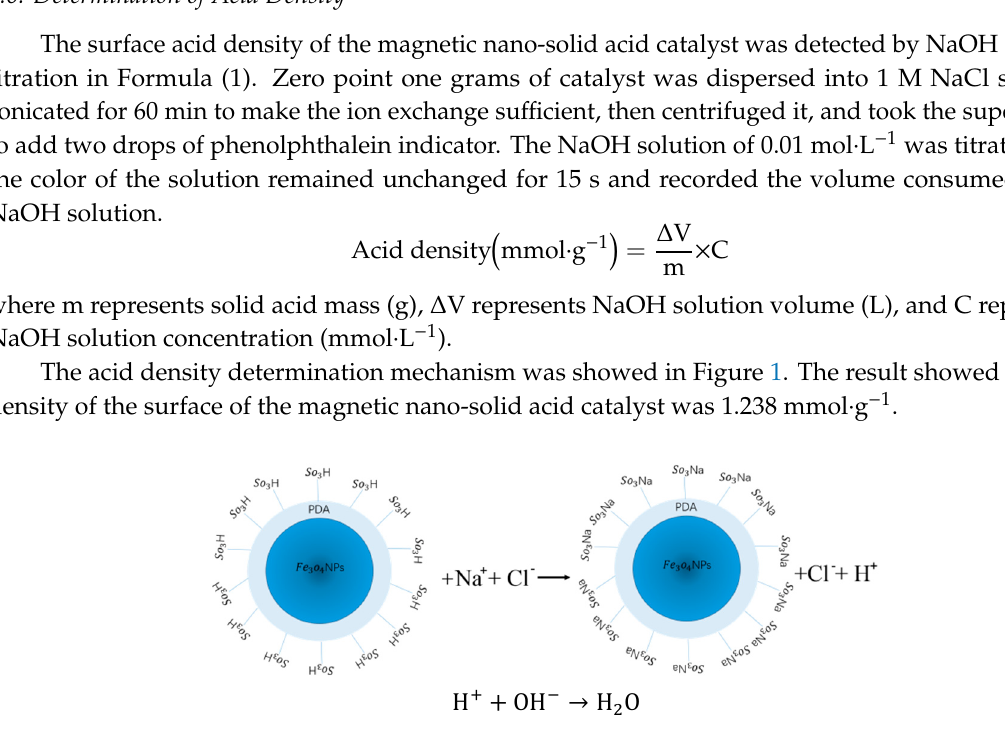
Figure 1. Acid density determination mechanism.